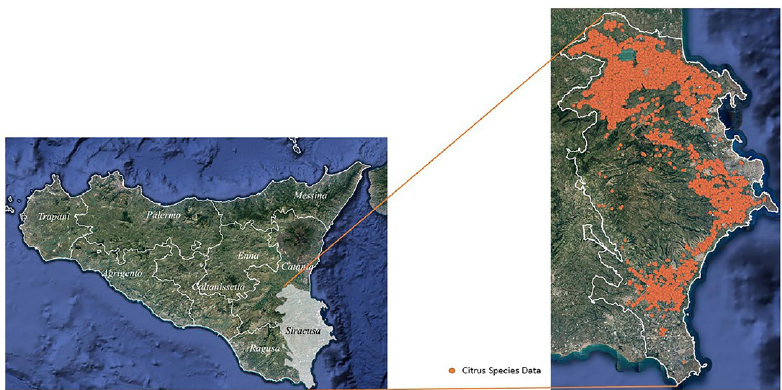
Figure 1. Location of Syracuse province within Sicily (Italy).